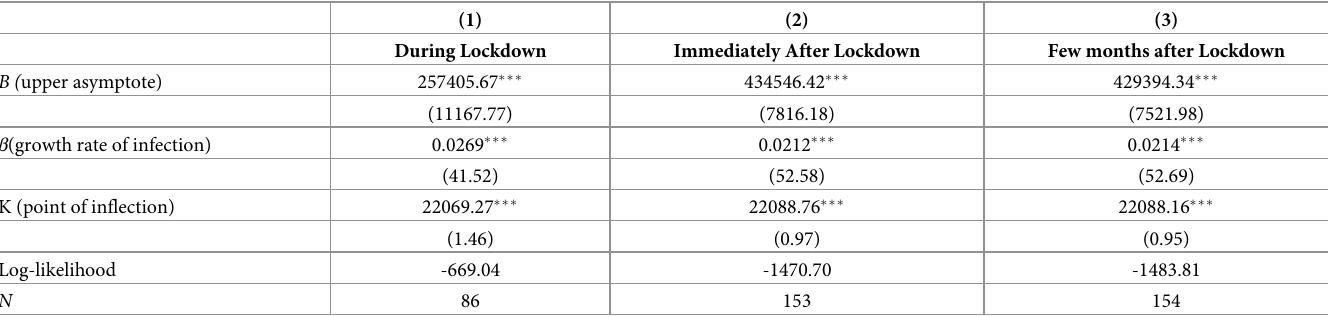
Table 2. Gompertz distribution: Parameter estimation (before and after lockdown).